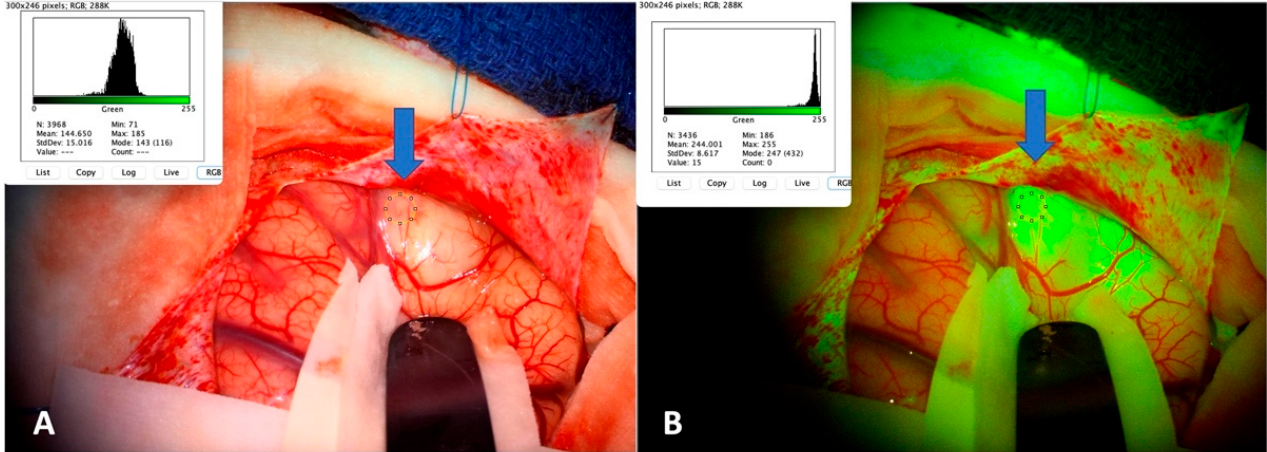
Figure 1. Example of image analysis for tumor tissue. For the selected ROI (blue arrows) the program gives a value of green ( A ) under white light, ( B ) under the YELLOW 560 nm filter. We performed the same analysis for the adjacent healthy tissue, both under white light and YELLOW 560 nm filter.